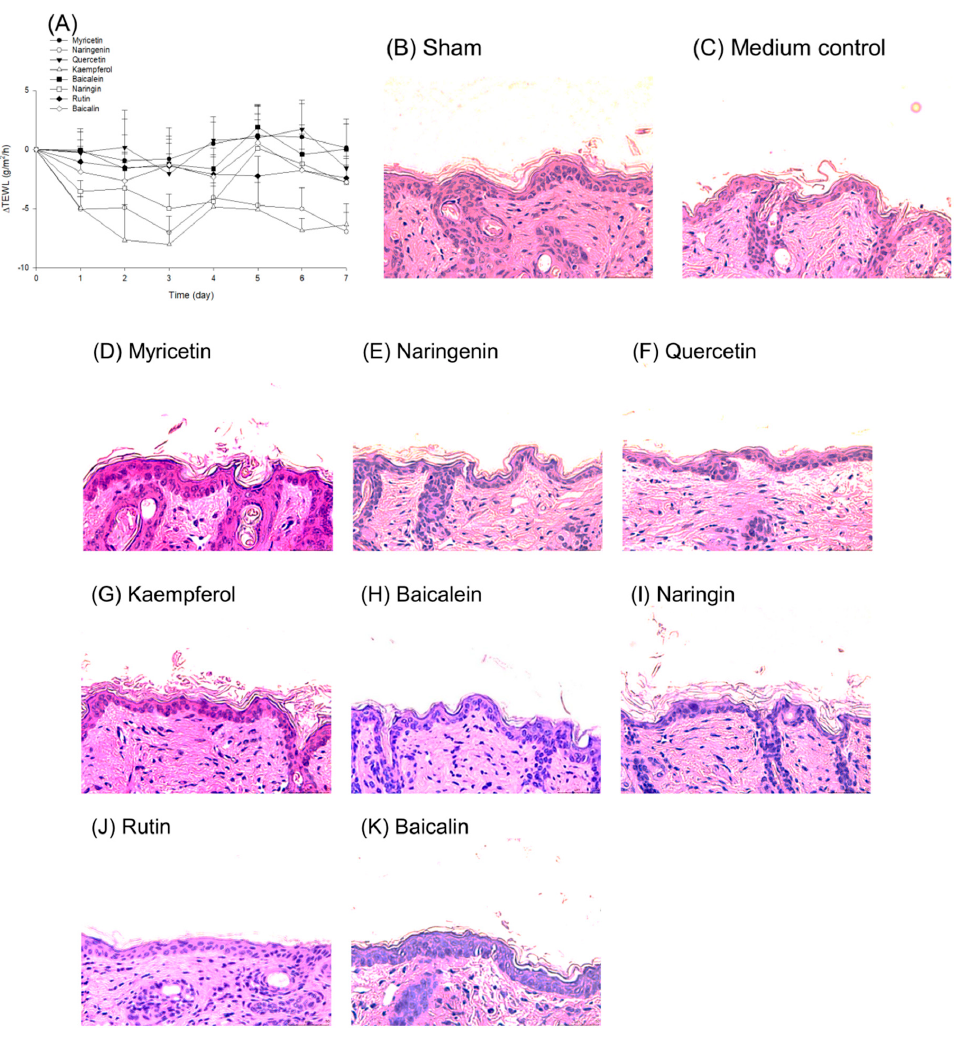
Figure 6 . The in vivo safety of topically applied flavonoids on skin after a 7-day exposure: ( A ) Δ TEWL-time curves; ( B ) the histology of sham control skin; ( C ) the histology of aqueous